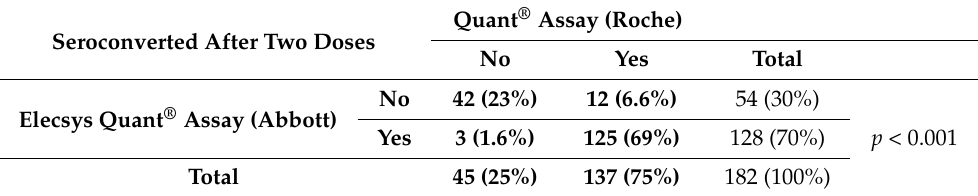
Table 2. Concordance of the seroconversion after two doses between Elecsys Quant ® Assay (Abbott) and Quant ® Assay (Roche) on 182 samples, showing a significant correlation.